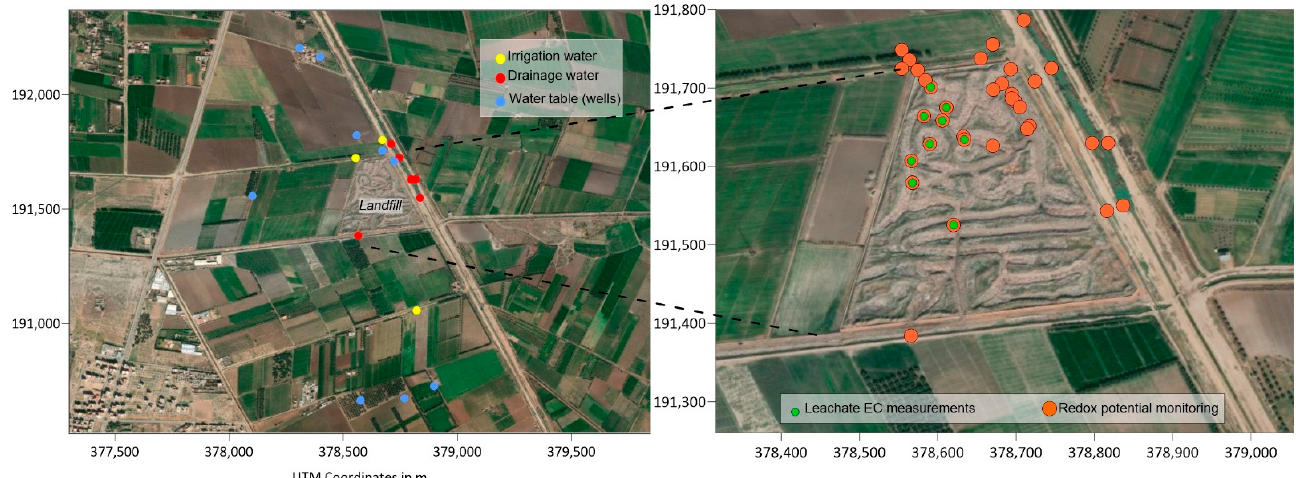
Figure 2. Location map of water characterisations measurement points (irrigation, drainage, groundwater and leachate water). Note that the waste is grouped in windrows within the landfill. UTM coordinates in metre using Lambert conical conformal projection (Morocco zone 1).